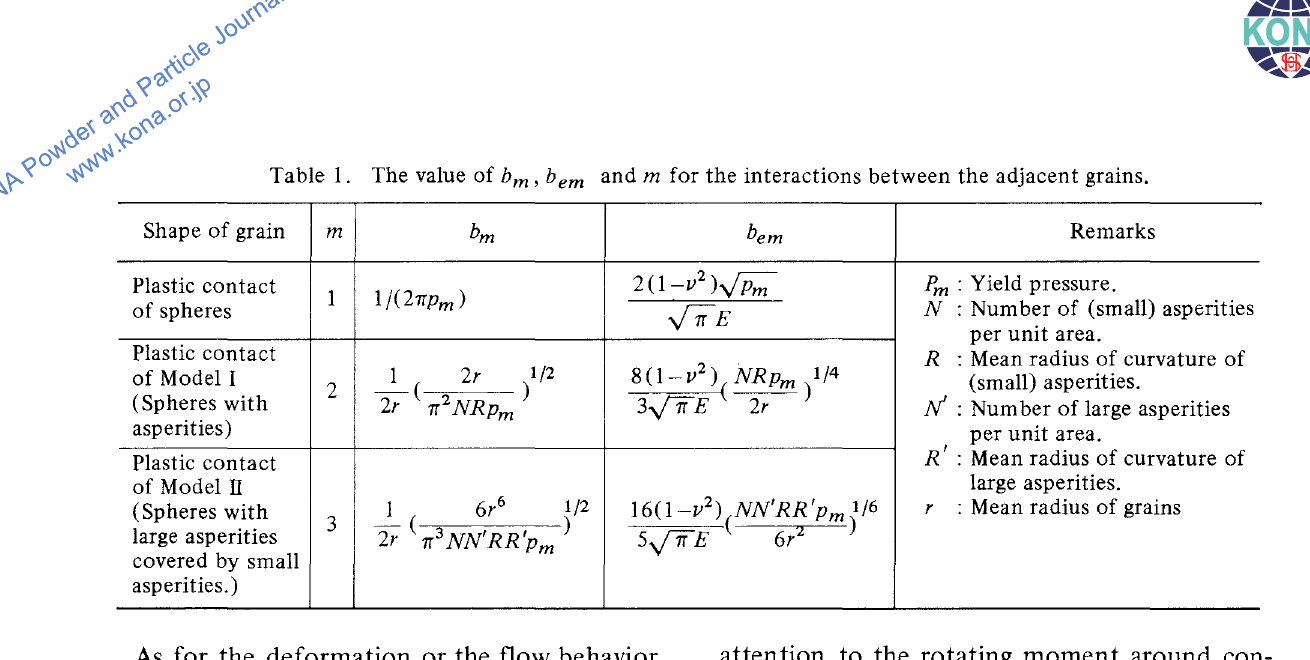
Table I. The value of bm, hem and m for the interactions between the adjacent grains. Shape of grain